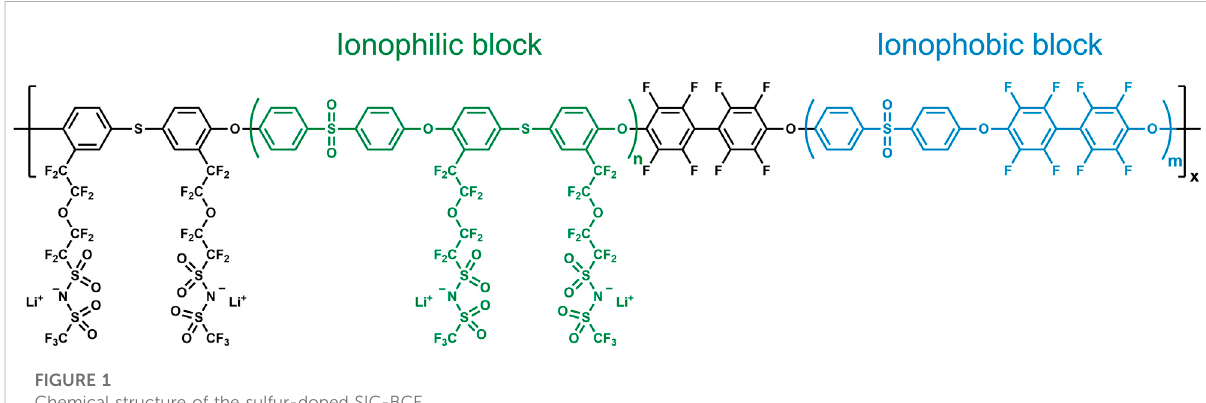
FIGURE 1 Chemical structure of the sulfur-doped